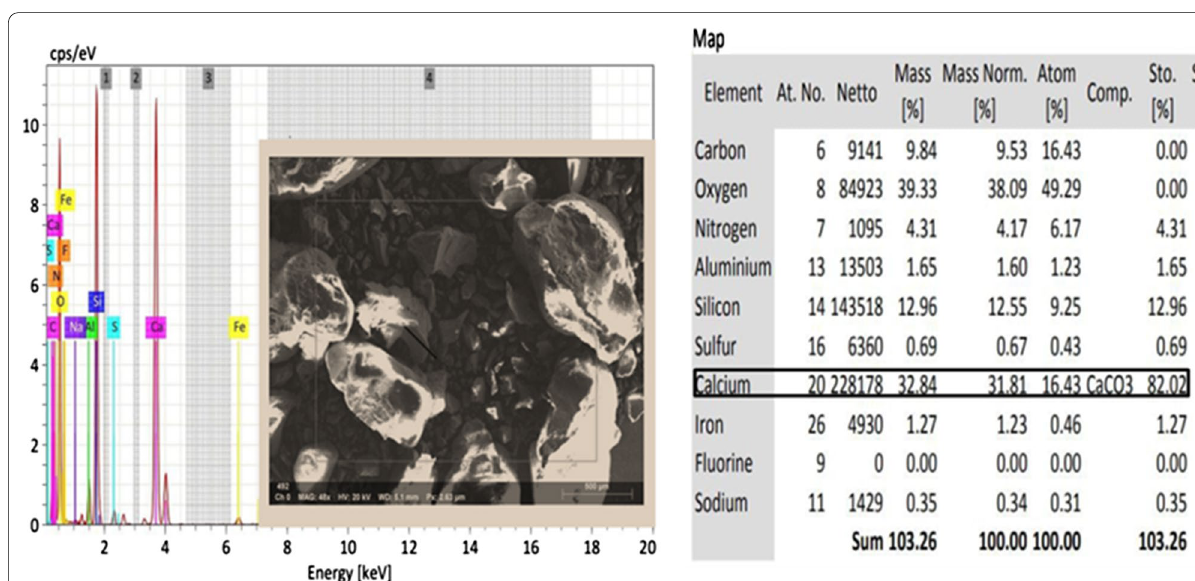
Fig. 7 Energy dispersive X‑ray analysis (EDX) of precipitated calcite in concrete of B2 ( Bacillus paramycoides ) bacterial